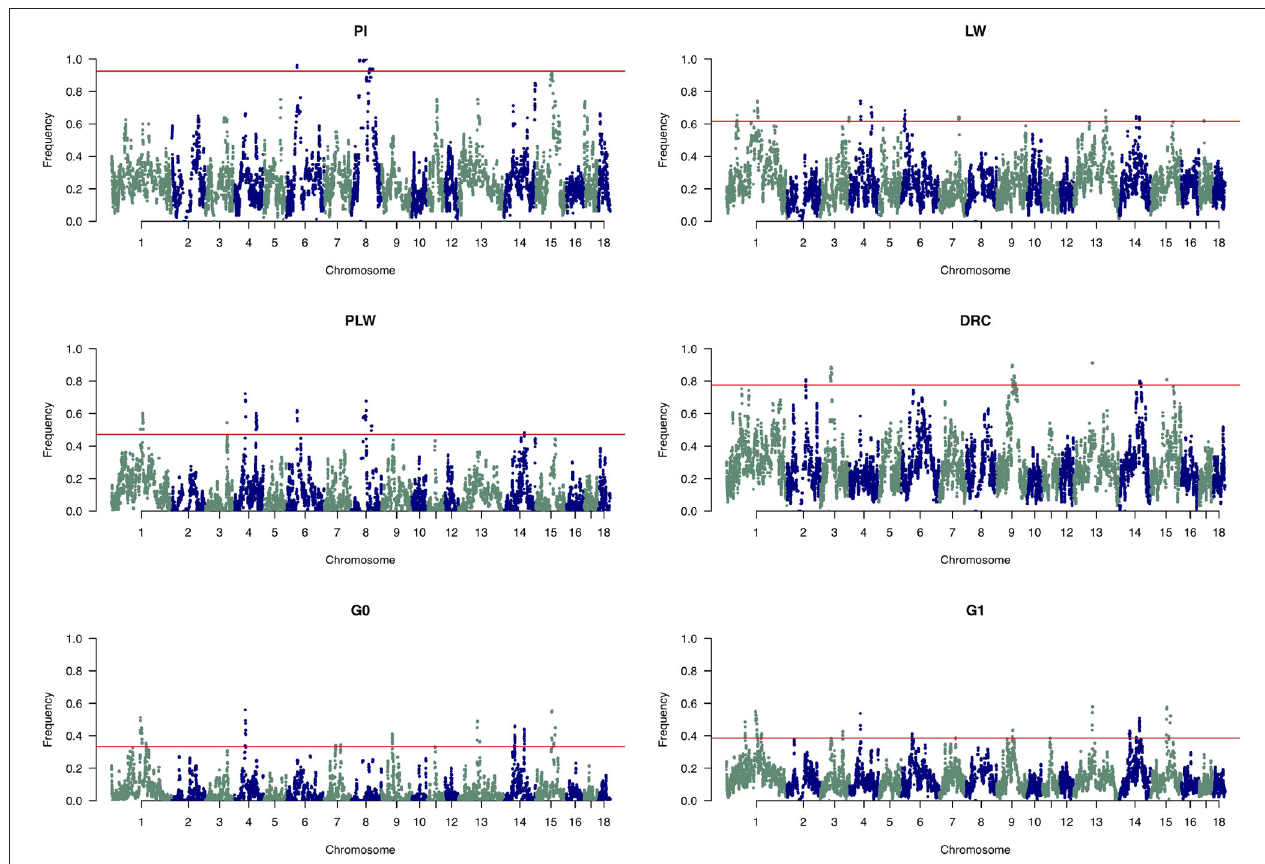
FIGURE 8 | Manhattan plots of the frequency of SNP detected inside a runs of homozygosity (ROH). The horizontal line indicates the cutoff level for ROH hotspot detection in each genetic group. It corresponds to the top 1% SNP most frequently observed in an ROH in each pure breed and crossbred population. DRC, Duroc; G0, (Pietrain × Large White) × Duroc offspring; G1, G0 × G0 offspring; LW, Large White; PI, Pietrain; PLW, Pietrain × Large